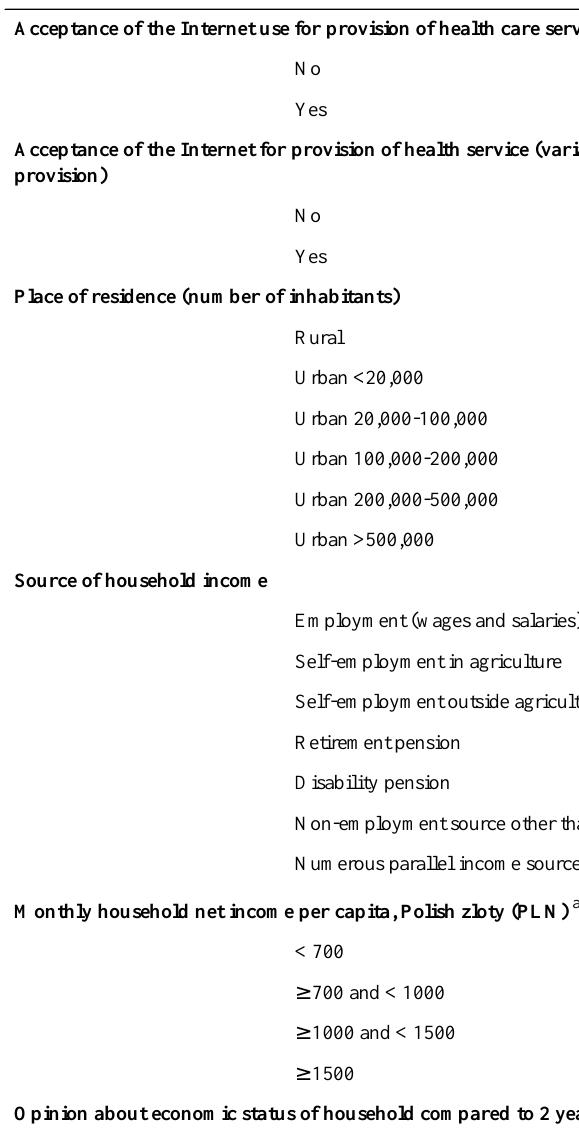
Table 1. The characteristics of households included in the multivariate logistic regression analysis (N = 8915).